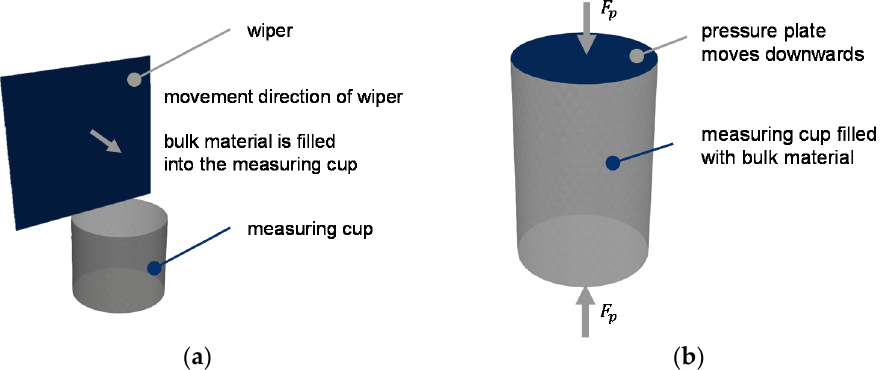
Figure 14. Simulation setup for the ( a ) bulk density; ( b ) compression behavior.